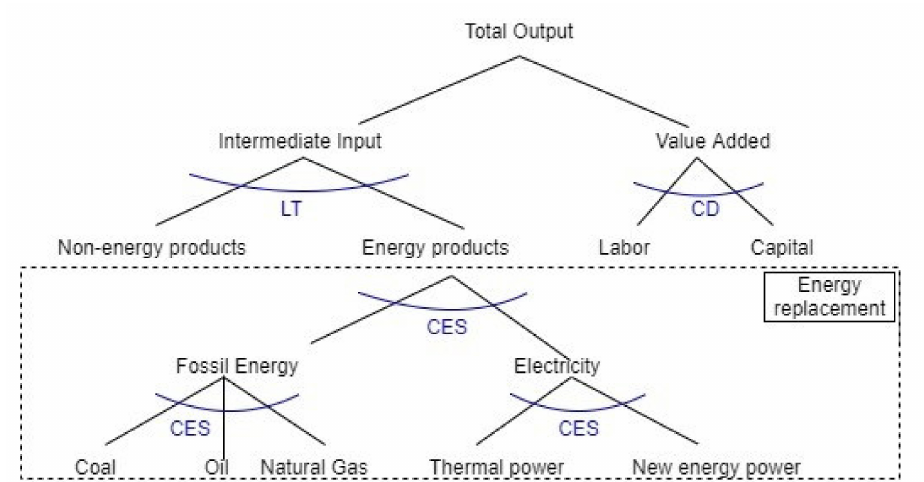
Figure 2. Production structure